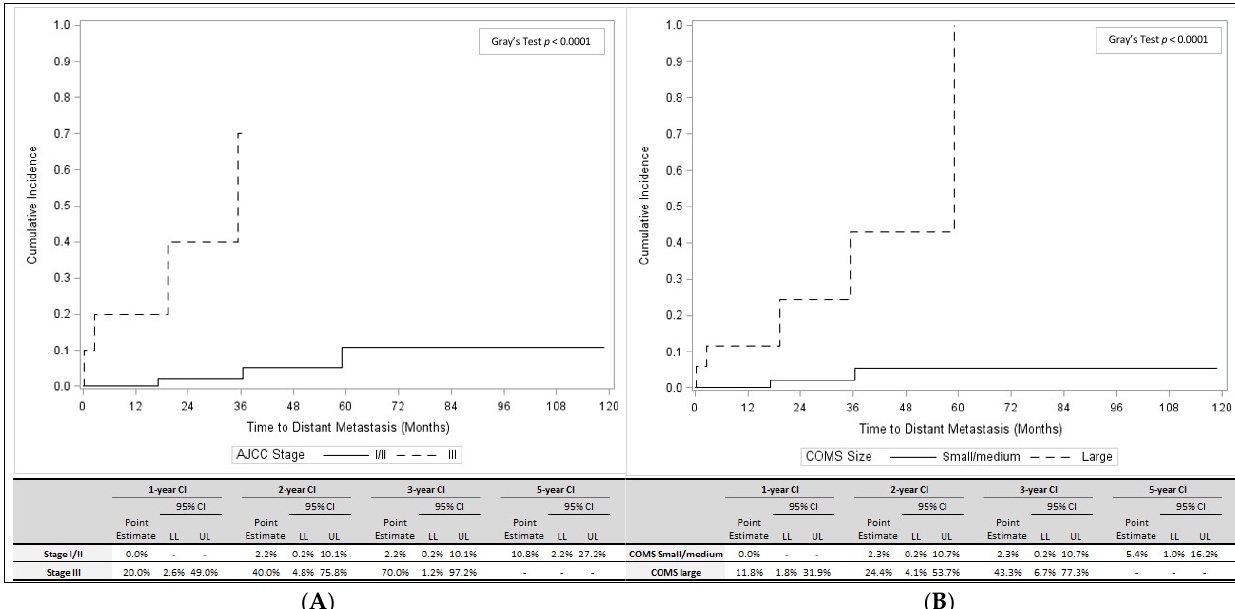
Figure 3. ( A ) . Cumulative incidence of distant metastasis for patients with AJCC stage I/II disease (solid line) and AJCC stage III disease (dashed line) is shown (top panel), including estimates for 1, 2, 3, and 5 years (bottom panel). ( B ) . Cumulative incidence of distant metastasis for patients with small/medium COMS size (solid line) and large COMS size (dashed line) is shown (top panel), including estimates for 1, 2, 3, and 5 years (bottom panel). Abbreviations: COMS, Collaborative Ocular Melanoma Study; HR, Hazard ratio; LL, Lower limit; UL, Upper Limit; CI, Confidence interval.